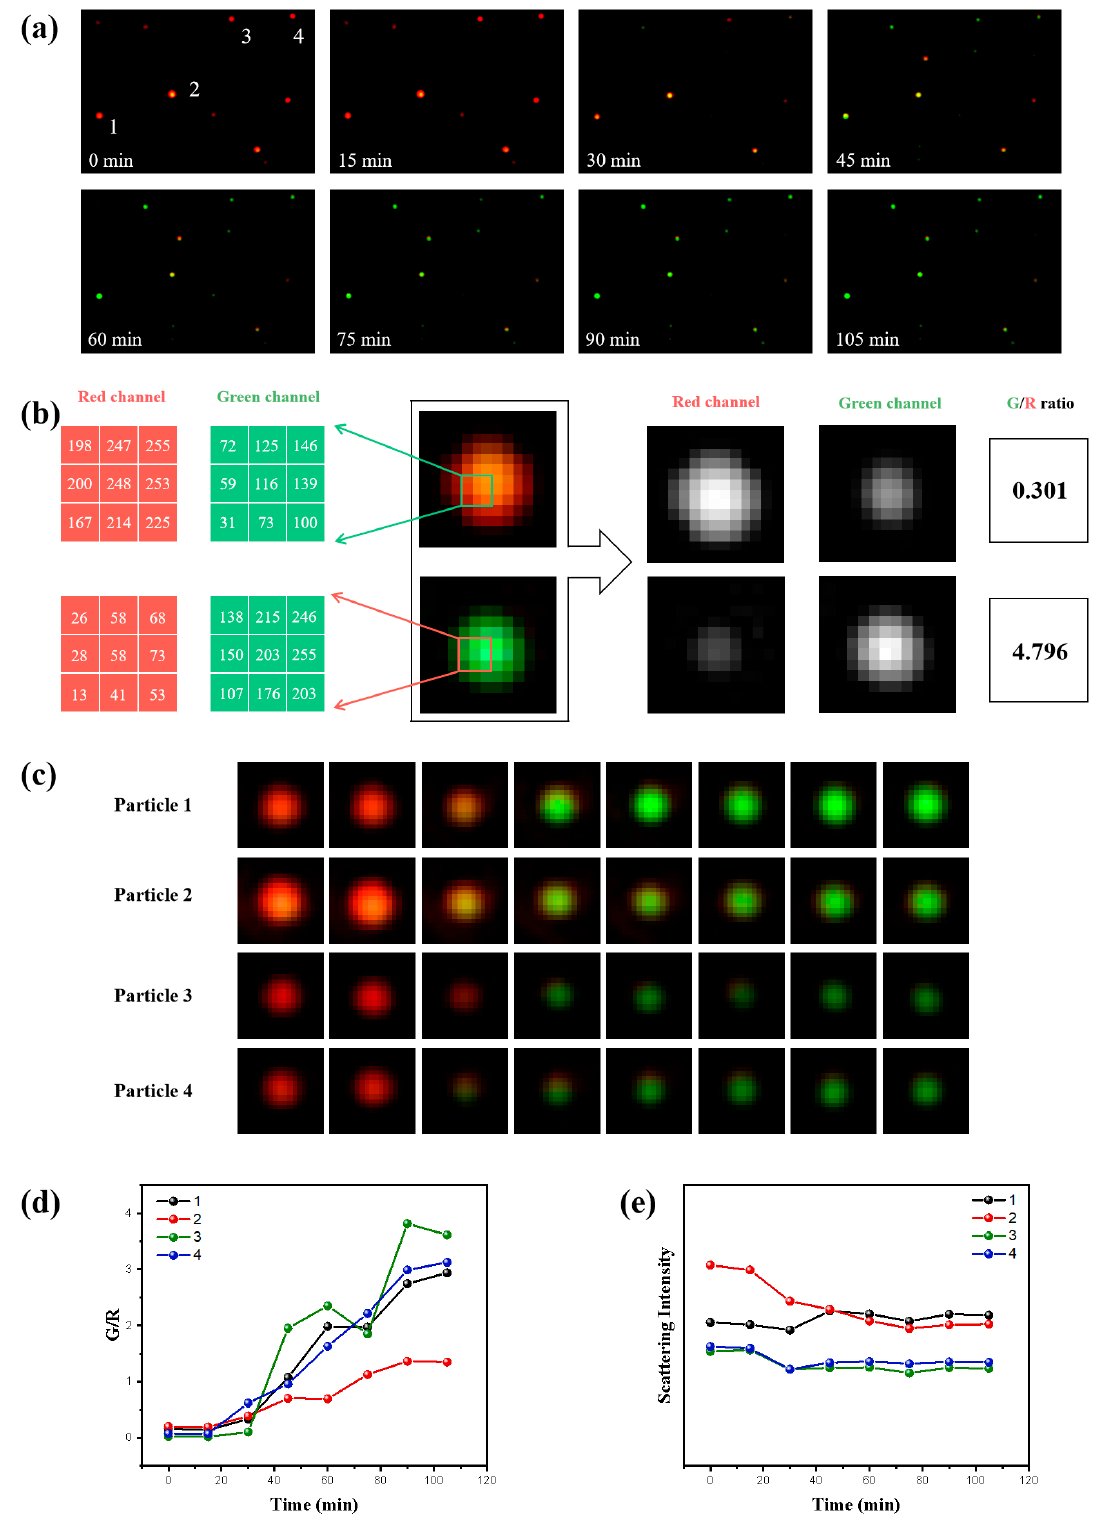
Figure 3. ( a ) Real-time monitoring of GNSs during the shape transformation induced by 0.5 µM iodide at an exposure time of 50 ms (the images were captured at 0, 15, 30, 45, 60, 75, 90, and 105 min). ( b ) R and G channel images of one selected GNS prior to and after transformation induced by iodide. ( c ) Images, ( d ) G/R ratio, and ( e ) scattering intensity of four selected GNSs.